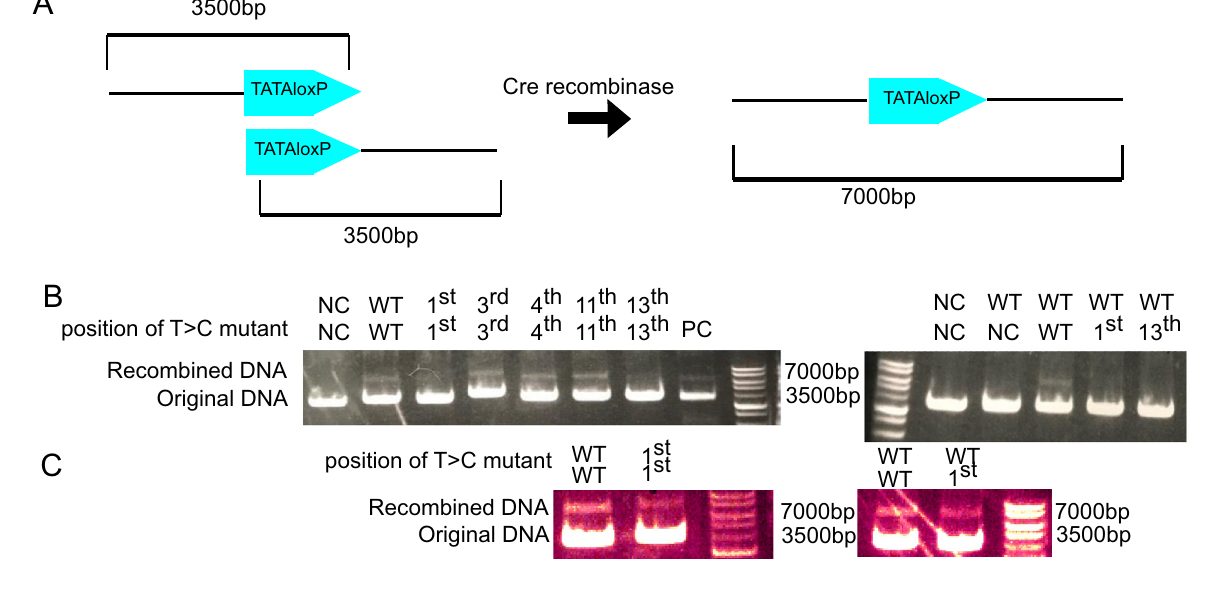
Figure 5. In vitro Screening of non-responsive TATAloxP with T > C mutations. ( A ) Schematic representation of the in vitro recombination assay with TATAloxP sequences. ( B , C ) Linear DNAs with different TATAloxP sequences containing the indicated mutations were incubated with Cre recombinase. Note that TATAloxP with the T > C mutation at the first base probably did not efficiently produce recombined DNA in the first experiment because of technical errors ( B ), but did so very well in the second experiment ( C ). (NC; No loxP, PC; positive control DNA in Cre recombinase (NEB Catlog#